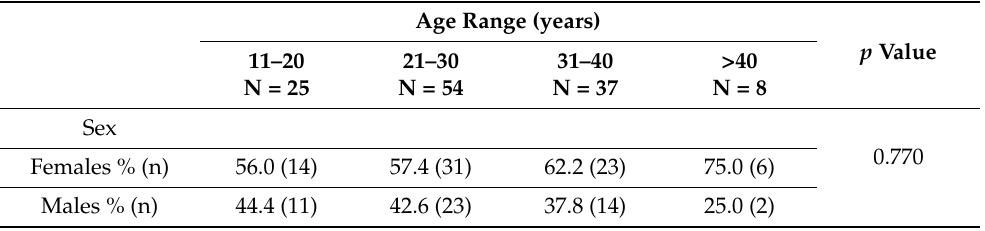
Table 2. A detailed age distribution at the time of surgery in the study group of patients.